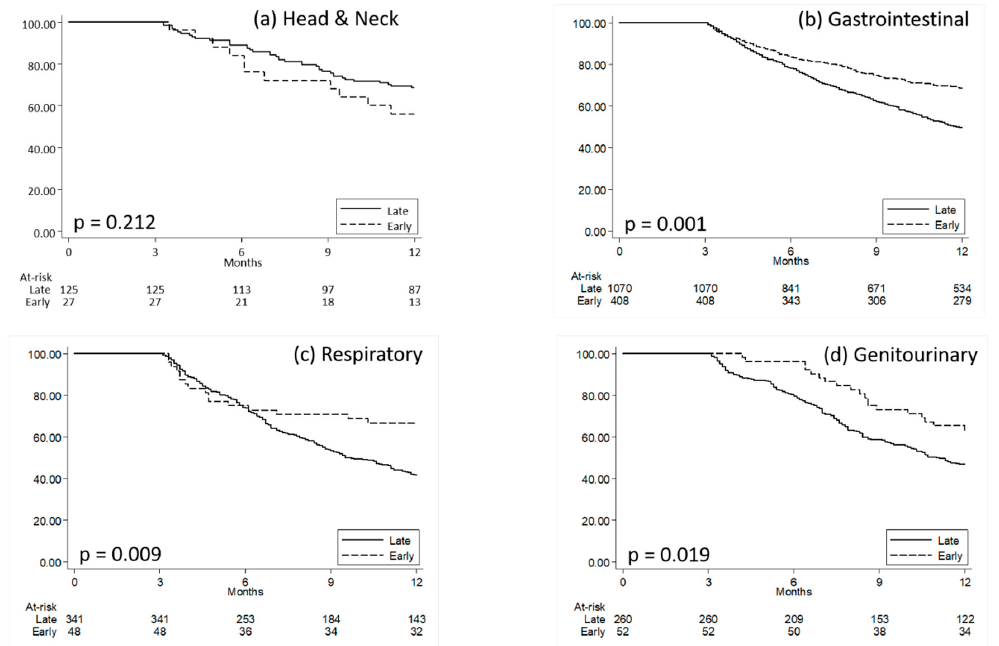
Figure 1. Kaplan–Meier curves comparing survival time since metastasis diagnosis for metastatic patients with early versus late clinical nutrition. ( a ) Head and Neck; ( b ) Gastrointestinal, ( c ) Respiratory, ( d ) Genitourinary. Quartiles of time (months) since metastasis diagnosis to first clinical nutrition prescription was calculated on all metastatic patients receiving clinical nutrition; patients were then classified as having an early or late administration when presenting a time since metastasis diagnosis to clinical nutrition administration below or above the first quartile, respectively. P: p - values from Log-Rank Tests.